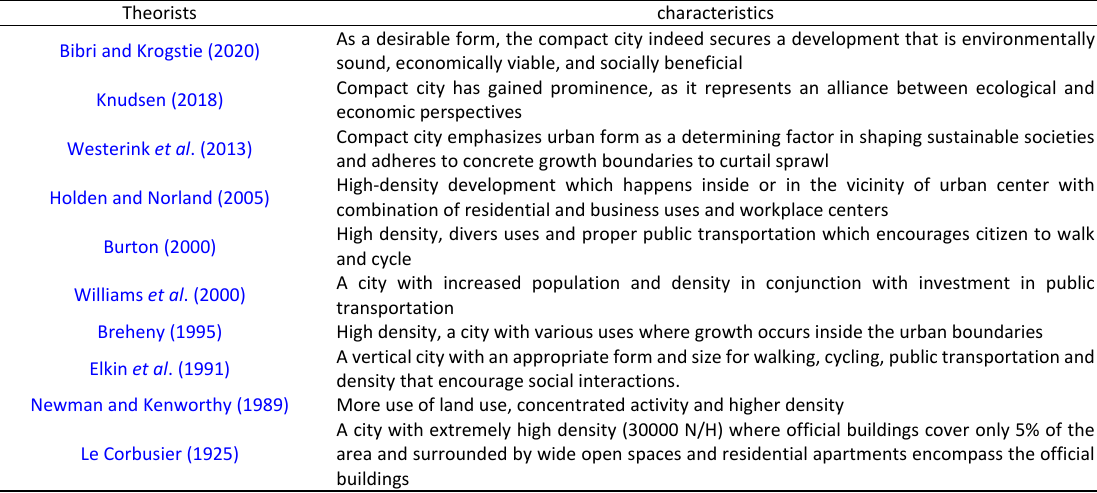
Table 2: Compact city characteristics